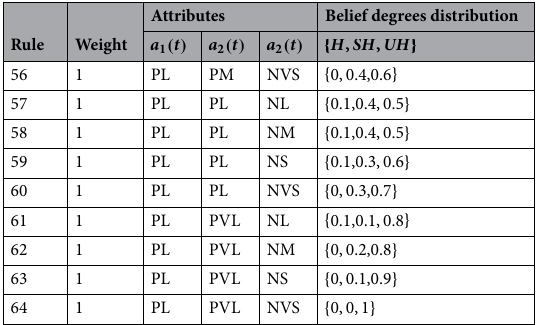
Table 5. Initial parameters of the BRB expert system.